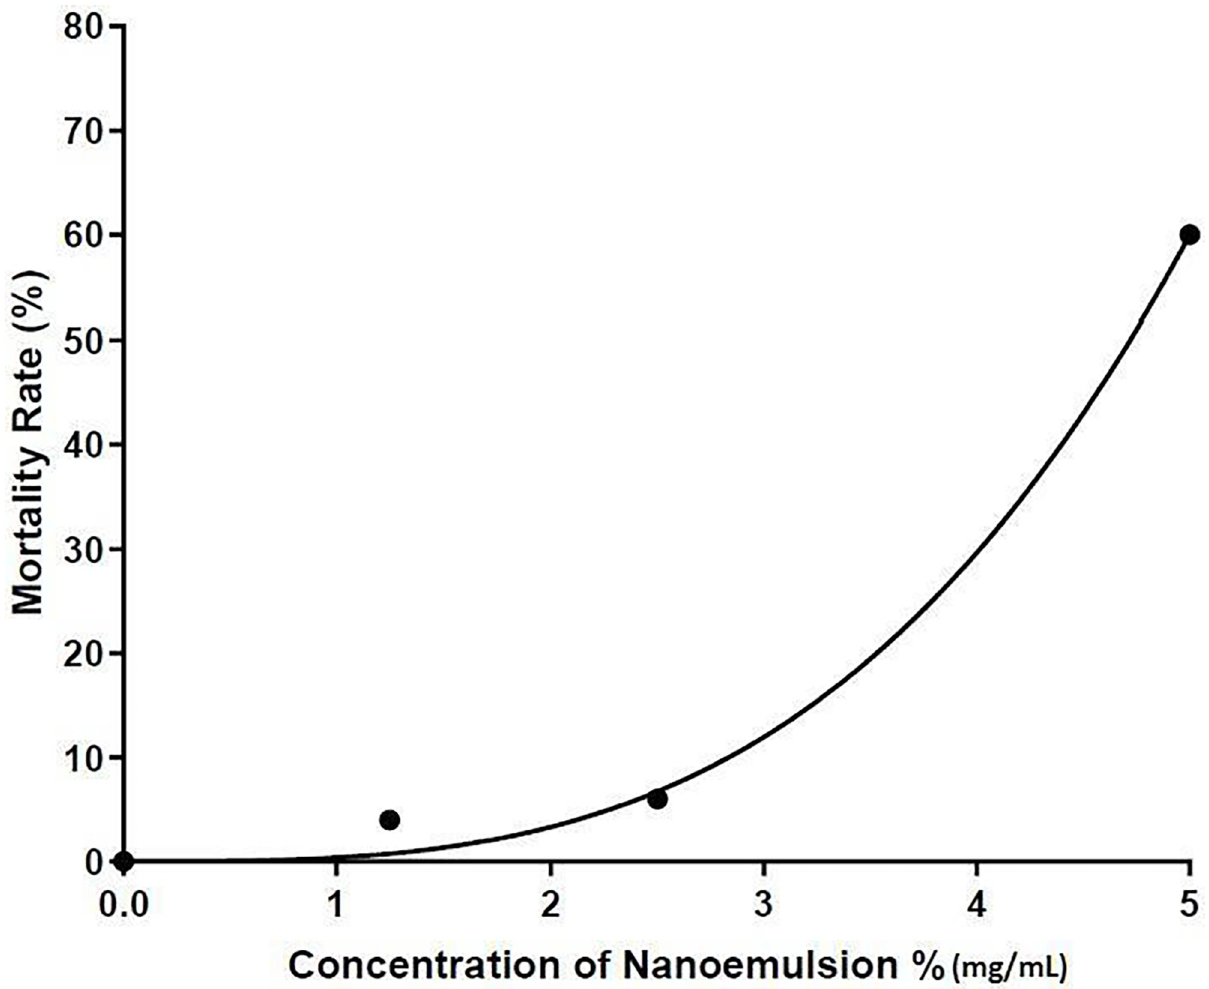
Fig 7. The effect of nanoemulsions on mortality rate of zebrafish (prolonged toxicity;n = 10).